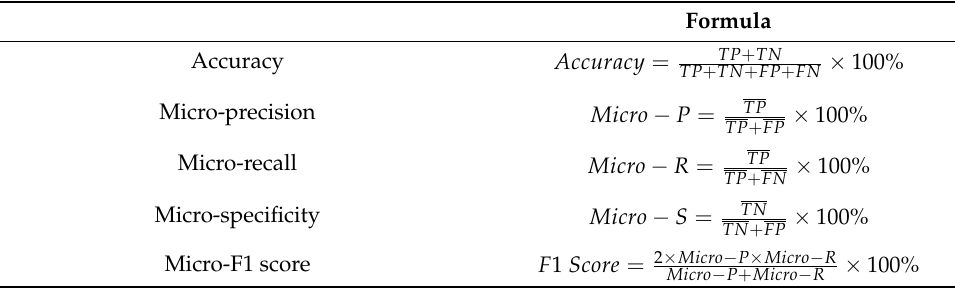
Table 4. Classification algorithm performance